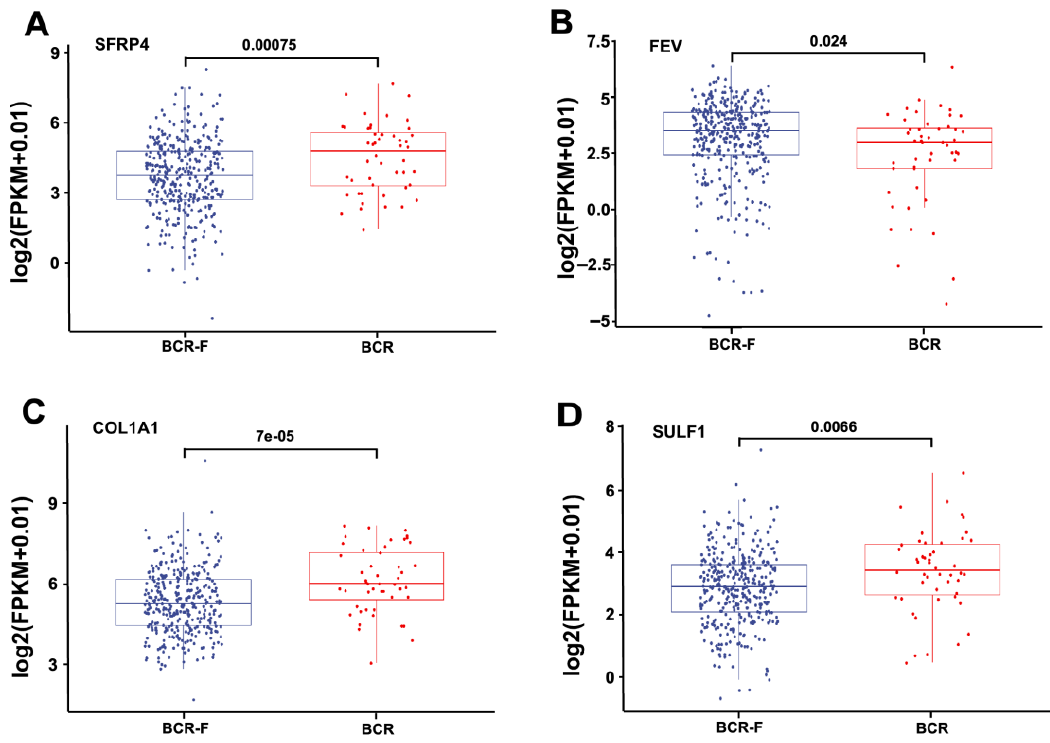
Figure 5. The expression of four genes in BCR and BCR-free groups. SFRP4 ( A ), FEV ( B ), COL1A1 ( C ), and SULF1 ( D ) expression levels in BCR and BCR-free PCa patients.